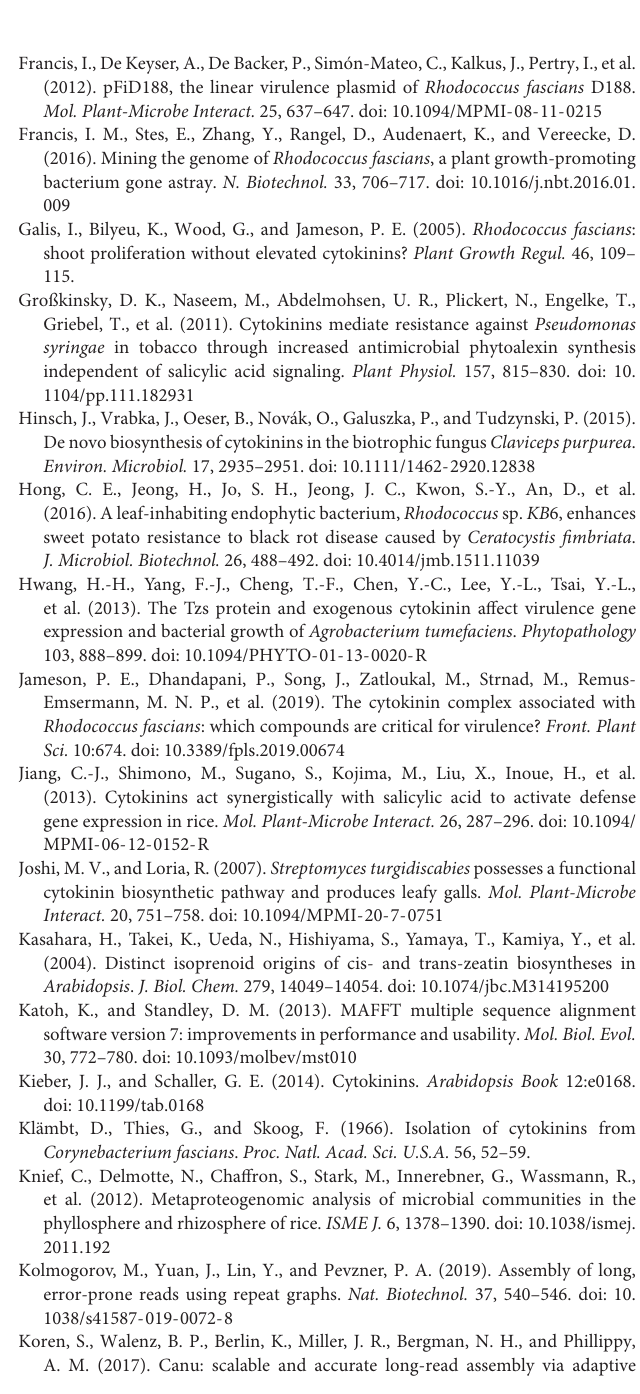
TABLE S1 | Oligonucleotides used in this study. TABLE S2 | Orthogroups containing at least one gene from two or more virulence plasmids. TABLE S3 | TBLASTN results of Leaf str.